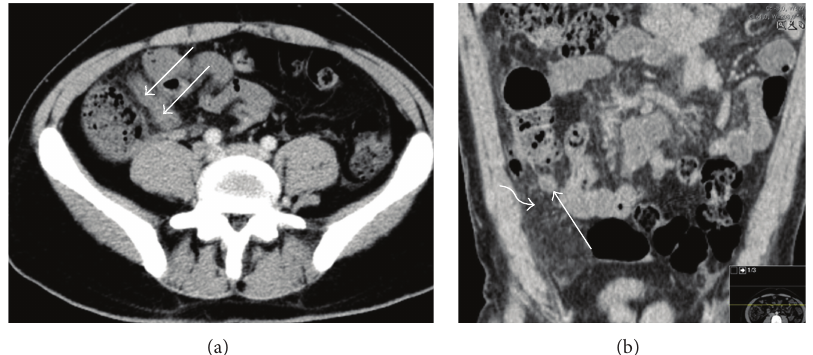
Figure 1: Axial contrast-enhanced (a) and coronal reconstruction (b) CT images obtained at the level of the lower abdomen show an enlarged and thick-walled appendix (arrows), with evidence of stranding of the surrounding mesenteric fat (curved arrow in (b)).